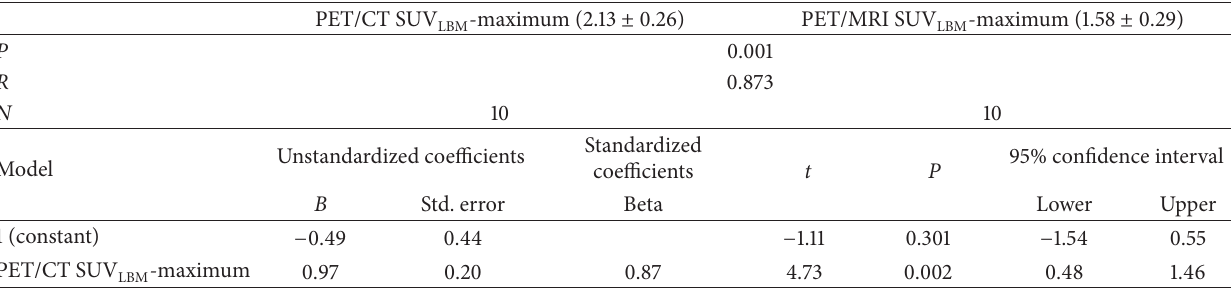
-maximum and PET/MRI SUV LBM